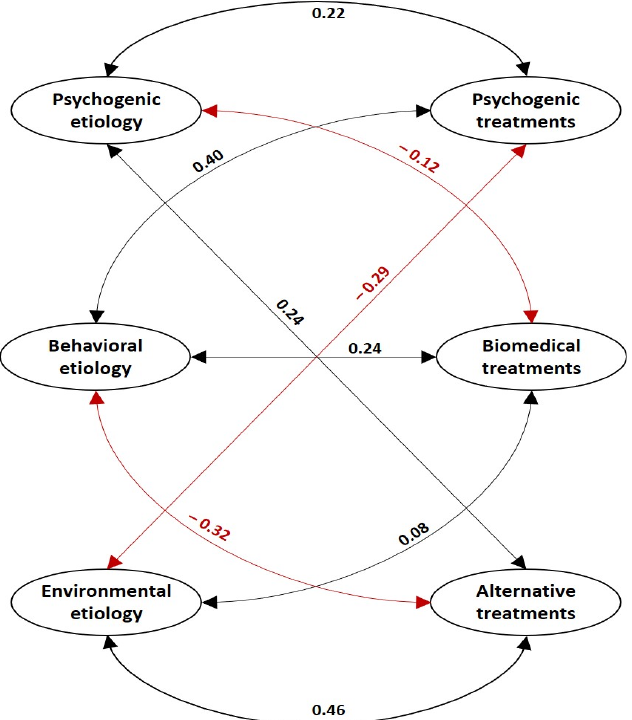
Figure 3. Explanatory model of the relationships between the constructs of the categories of attributions to the cancer etiology and to the treatment efficacy. The black arrows show direct (positive) relationships and the red arrows show inverse (negative) relationships. All data have p -values < 0.001. NFI 0.622, IFI 0.681, TLI 0.640, CFI 0.677, and RMSEA 0.093.